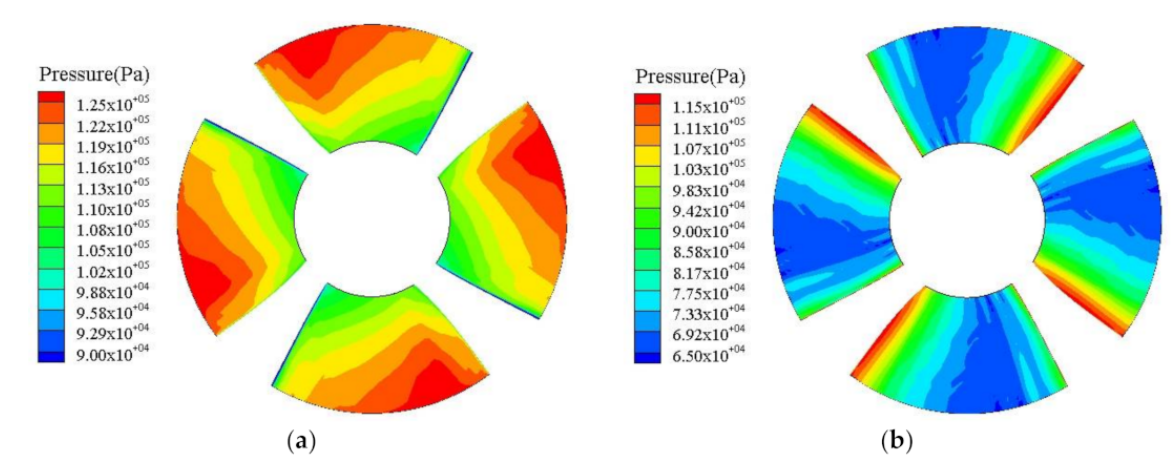
Figure 9. Pressure distribution on the blade surface of the axial-flow pump under the flow Q bep : ( a ) the pressure distribution of the blade PS, ( b ) the pressure distribution of the blade